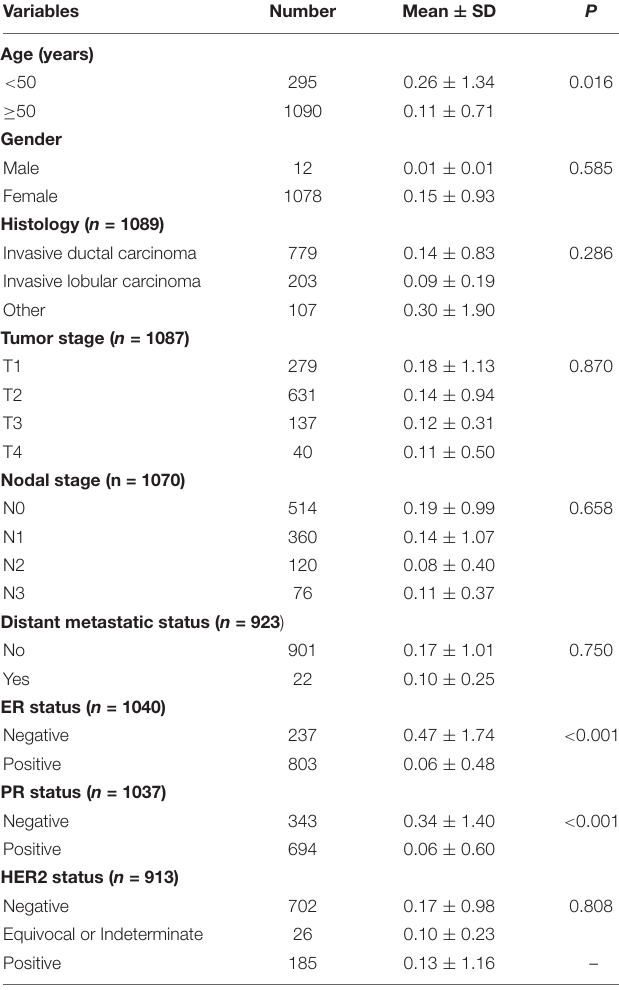
TABLE 1 | The correlation between clinical characteristic parameters and the expression of CMTM5 in breast